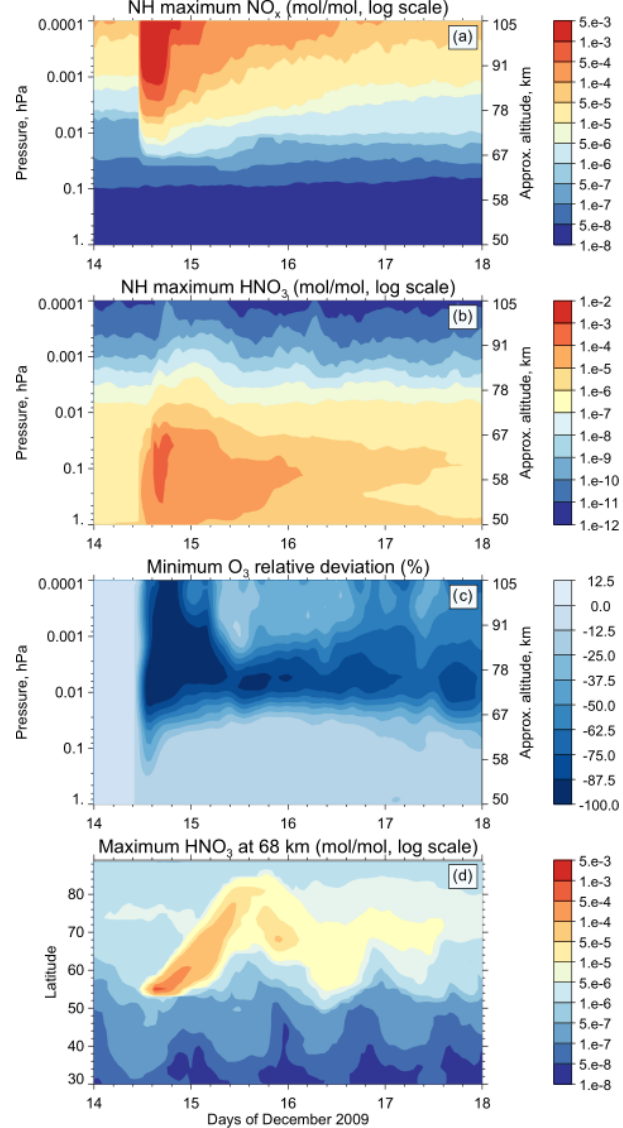
Figure 7. HAMMONIA results for the (a) northern hemispheric (NH) maximum value of NO x volume mixing ratio (VMR). (b) NH maximum value of HNO 3 VMR. (c) NH minimum ozone value of the relative difference between runs with and without the event and (d) zonal maximum value of HNO 3 VMR at